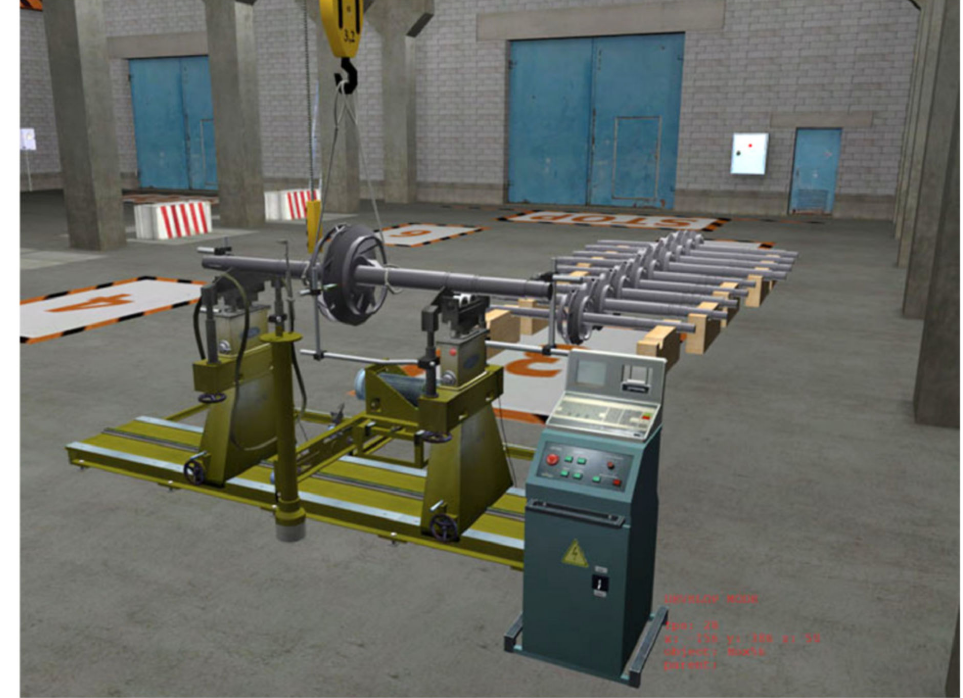
Figure 7. Model shows an industrial device created by SRI of electronic educational resources